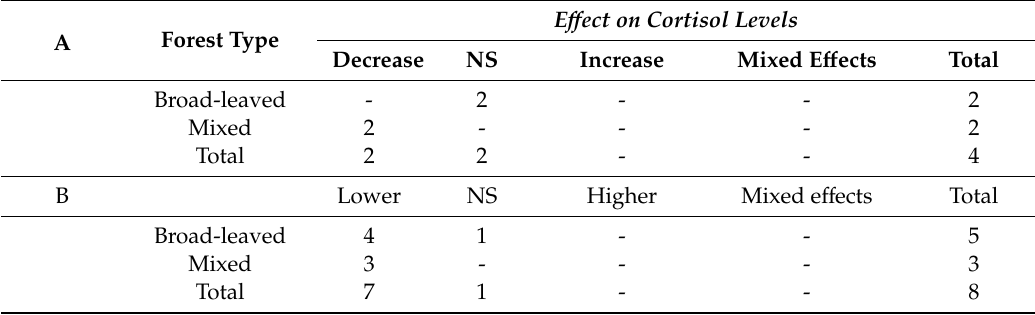
Table 5. E ff ects of forest type on cortisol levels in the (A) before-after studies and the (B) control trials. NS, not